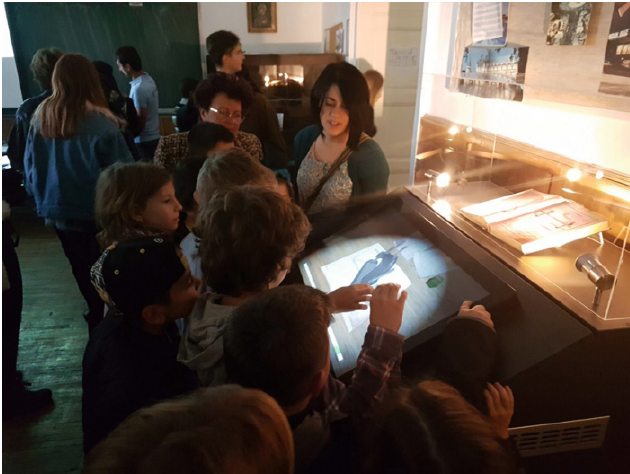
Figure 7. A 3D-augmented book titled Constitutio Criminalis Theresiana (also known as Nemesis Theresiana ). Courtesy of Dugulean ă M. [65].